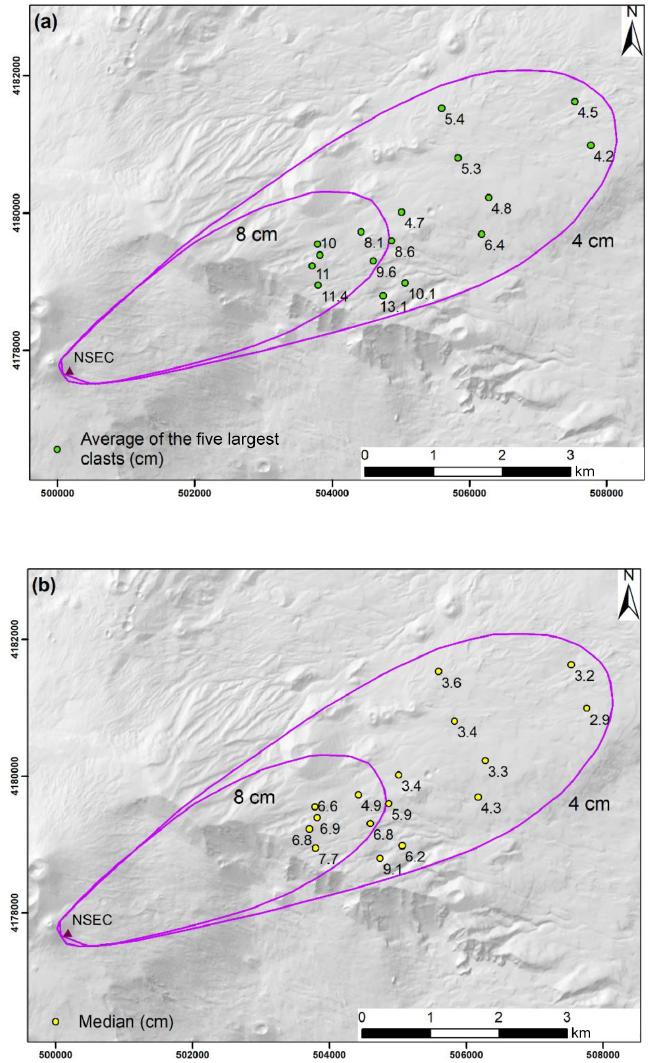
Figure A2. Comparison of modelled contours for 4 and 8cm (compiled using the model of Rossi et al., 2019) and field data values calculated using (a) the average of the five largest clasts (considering all three sampling areas at each location) and (b) the median values (considering all three sampling areas at each location). Note that to facilitate the comparison, model contours are the same in both figures, while observation data are different, i.e. average of five largest clasts and median values,